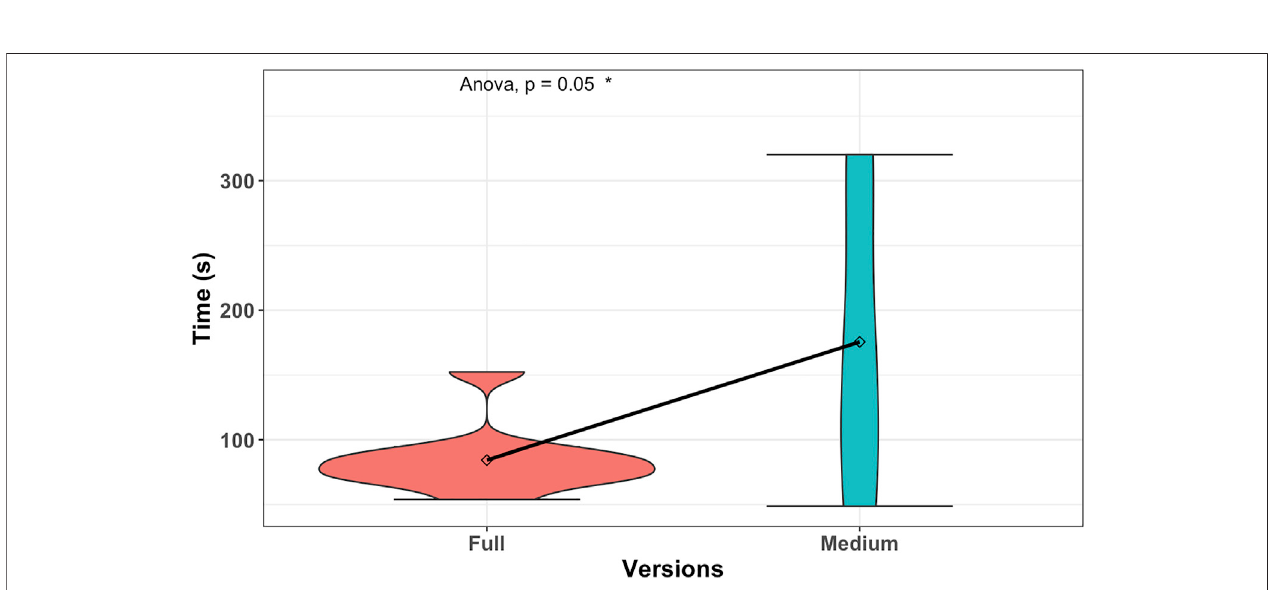
FIGURE 9 | Detailed analysis of time spent on the correct result of different levels of proactive behavior; the graph aims to show the difference between how much time the users spend while reaching the correct results in phase 1.